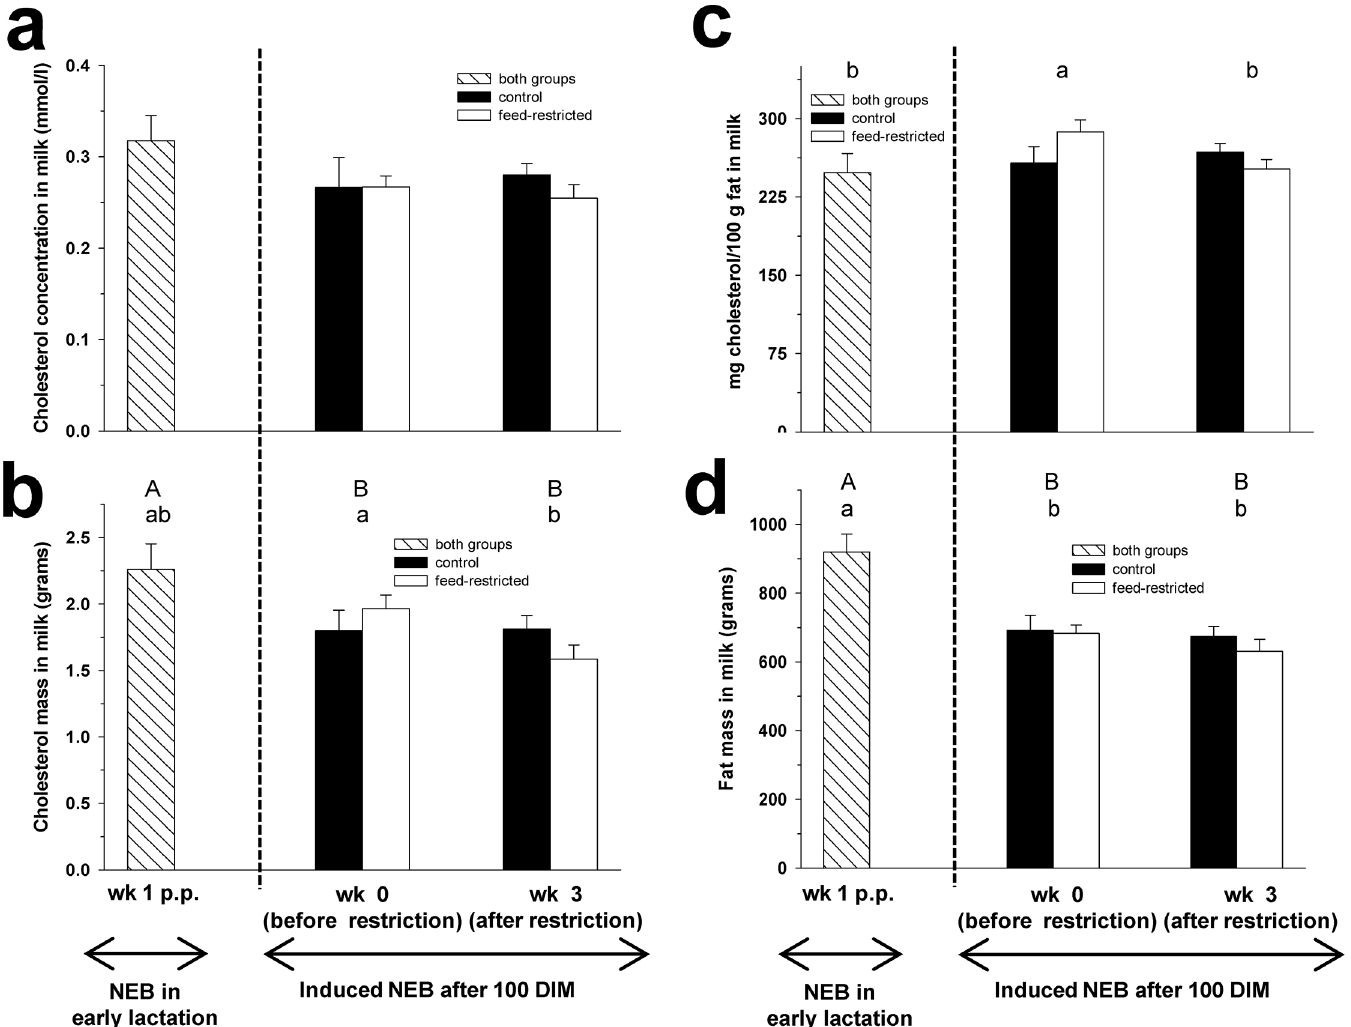
Fig 5. Milk cholesterol. Cholesterol concentration (mmol/l) in milk (Fig 5a), cholesterol mass (grams) in milk (Fig 5b), cholesterol concentration in milk fat (mg cholesterol per 100 g fat; Fig 5c) and fat mass (grams) in milk (Fig 5d) in week 1 p.p., and before (week 0) and after (week 3) feed restriction in mid- lactation. Changes over time within the groups are marked with superscripts (A and B for the control group (CON); a and b for the feed-restricted group (RES); P < 0.05). Data are presented as means ± standard error of the